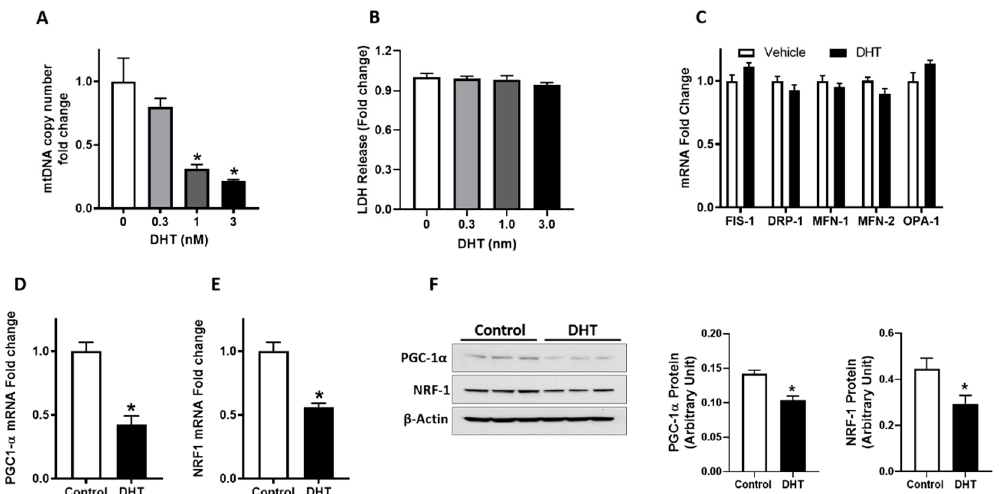
Figure 5. Mitochondrial copy number and expression of fission / fusion and biogenesis indicators. Trophoblastscellsweretreatedwithvehicle(ethanol)ordihydrotestosterone(DHT)for24h. ( A )Mitochondrial DNA copy number was quantified using qRT-PCR based analysis. ( B ) Cell viability after exposure to DHT was assessed using lactate dehydrogenase (LDH) cytotoxicity assay. The LDH levels were measured and expressed as the fold change compared to vehicle control. Real-time PCR was used to assess the relative mRNA expression levels of ( C ) fission / fusion genes (FIS-1, DRP-1, MFN-1, MFN-2, and OPA-1), and biogenesis indicators ( D ) PGC-1 α and ( E ) NRF1, normalized to β -actin. ( F ) Representative Western blots for PGC-1 α , NRF-1, and β -actin are shown at the left; blot density obtained from densitometric scanning of PGC-1 α and NRF-1 normalized to β -actin is shown at the right data presented as means ± SEM of 4 biologically independent replicates. * p < 0.05 vs.